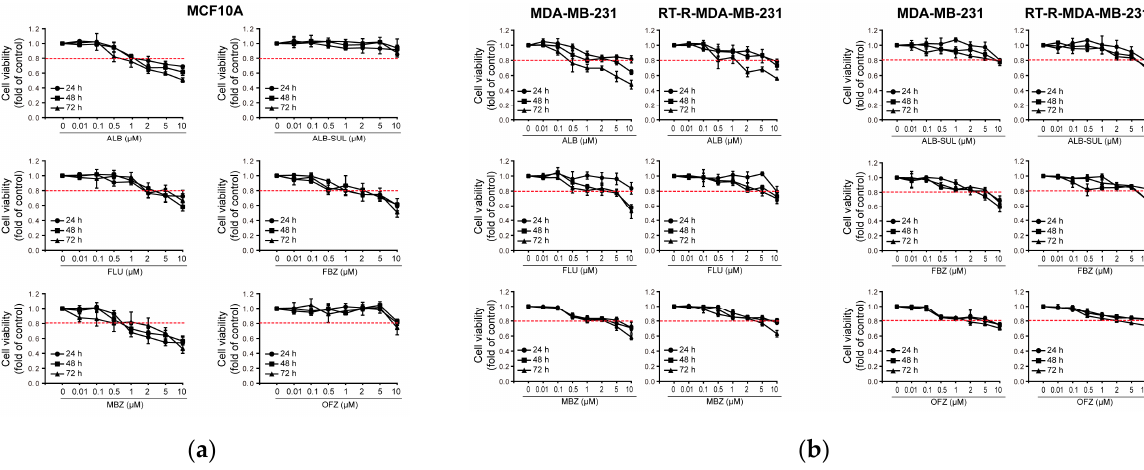
Figure 2. Effect of benzimidazole derivatives on the viability of normal breast epithelial cell MCF10A cells and breast cancer MDA-MB-231 and RT-R-MDA-MB-231 cells. ( a ) MCF10A, normal breast epithelial cells, or ( b ) breast cancer MDA-MB-231 and RT-R-MDA-MB-231 cells were treated with six benzimidazole derivatives (ALB, ALB-SUL, FLU, FBZ, MBZ, and OFZ) at the indicated concentrations (0.01, 0.1, 0.5, 1, 2, 5, 10 µ M) for 24–72 h, and then cell viability was determined by the CCK assay. The values are expressed as the means ± SD from three independent